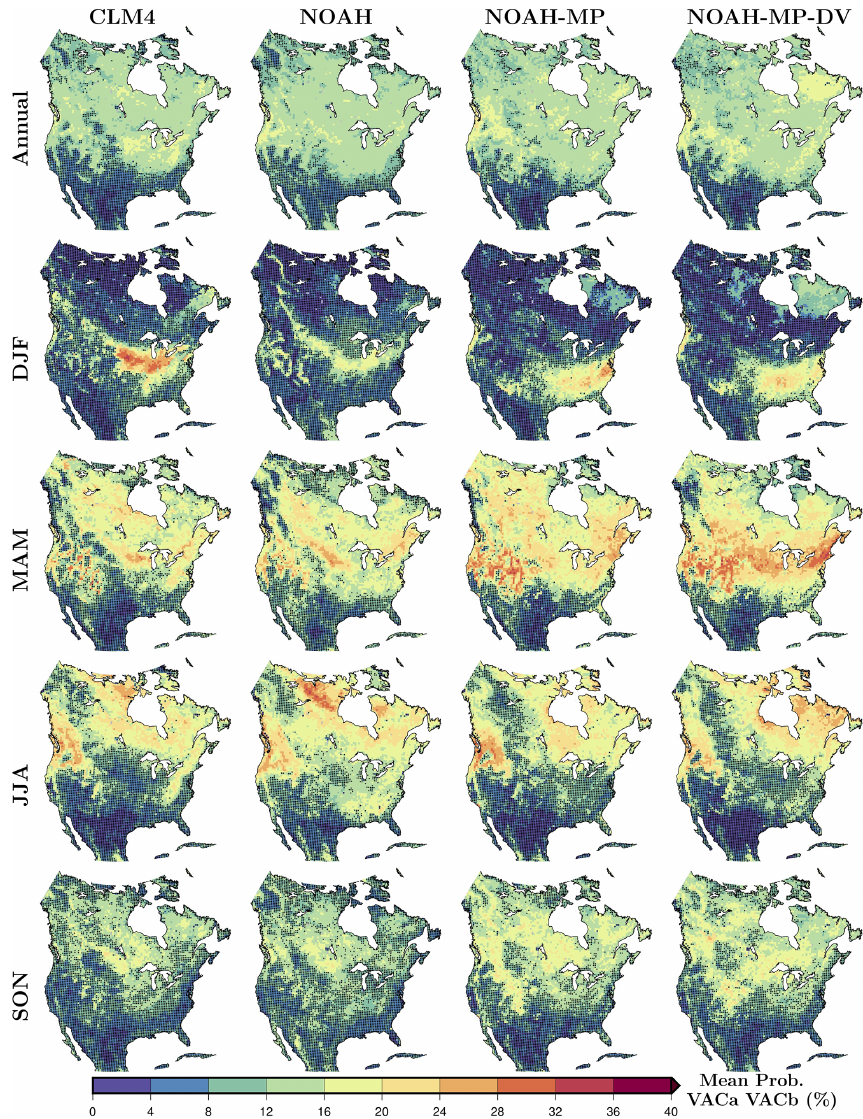
Figure 1. Mean frequency of occurrence for VAC categories associated with atmospheric control (VAC a and VAC b ) for each simulation annually and seasonally; DJF, MAM, JJA and SON. Black dots in the maps indicate VAC values lower than the 95th percentile of the randomly generated series and therefore areas with no significant